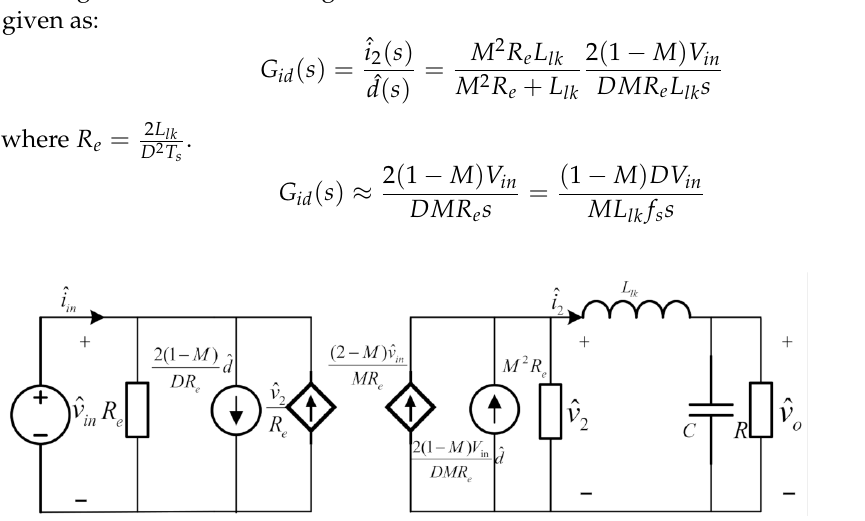
Figure 11. Small-signal model in buck mode.